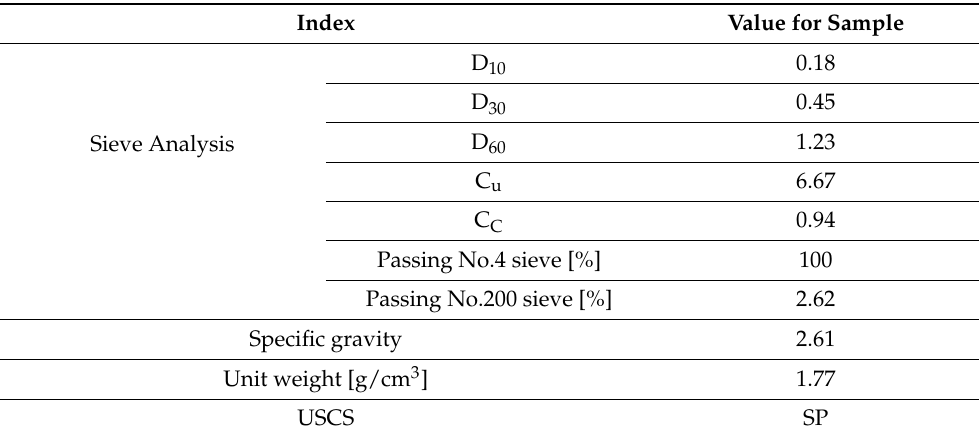
Table 1. Properties of weathered residual